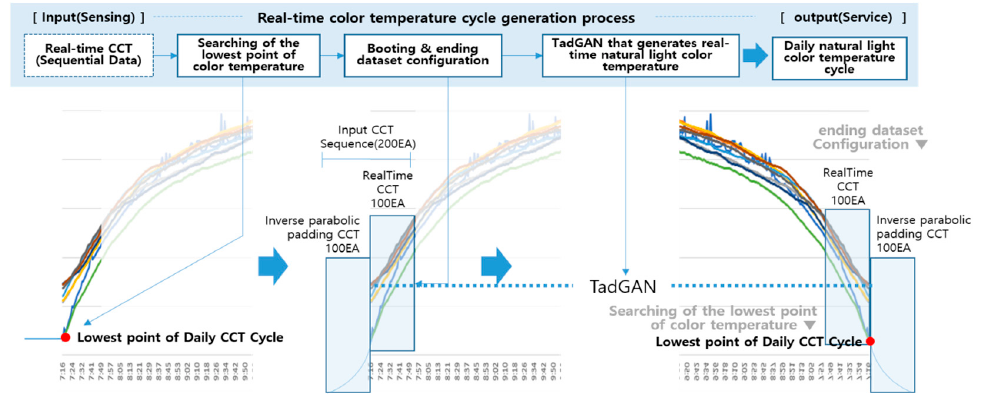
Figure 4. A process of generating real ‐ time natural light color temperature cycle .